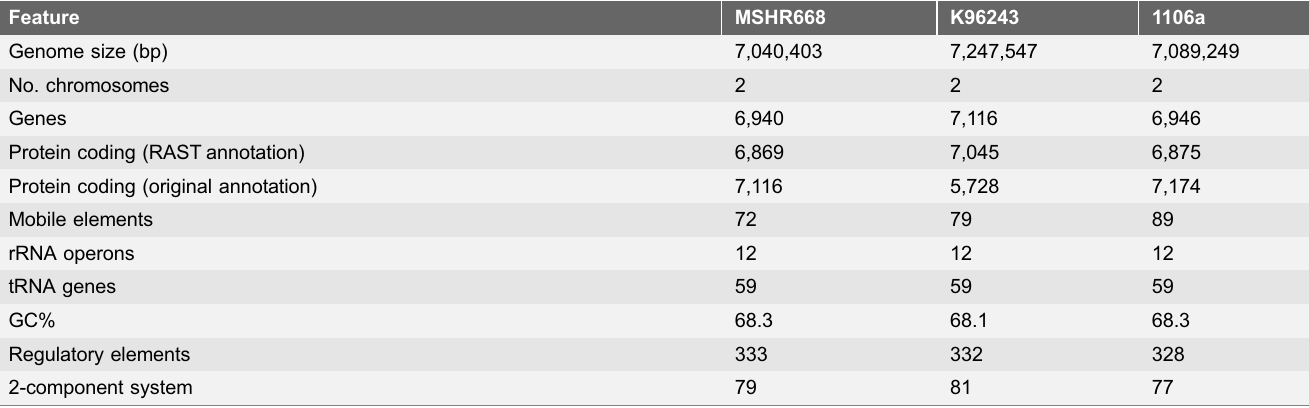
Table 2. General genome